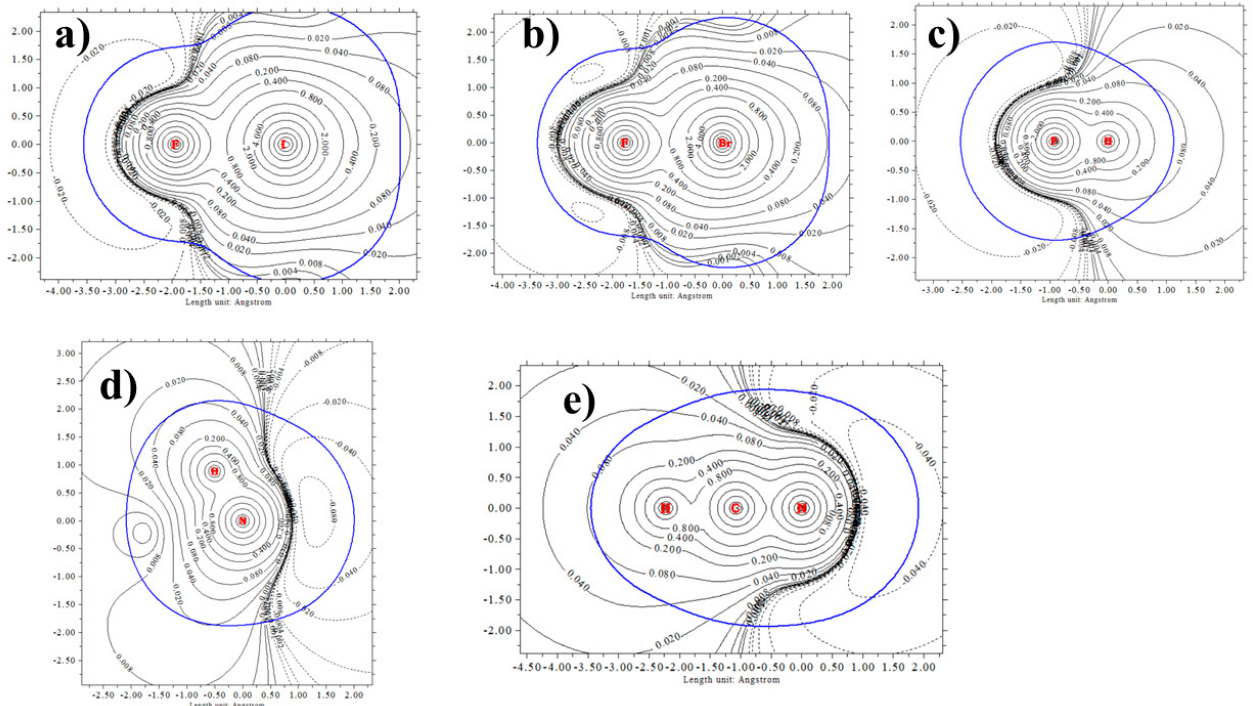
Figure 4. Contour plots of MEP of ( a ) FI, ( b ) FBr, ( c ) FH, ( d ) NH 3 and ( e ) NCH. Blue line represents a vdW surface defined as isodensity ρ = 0.001 au.